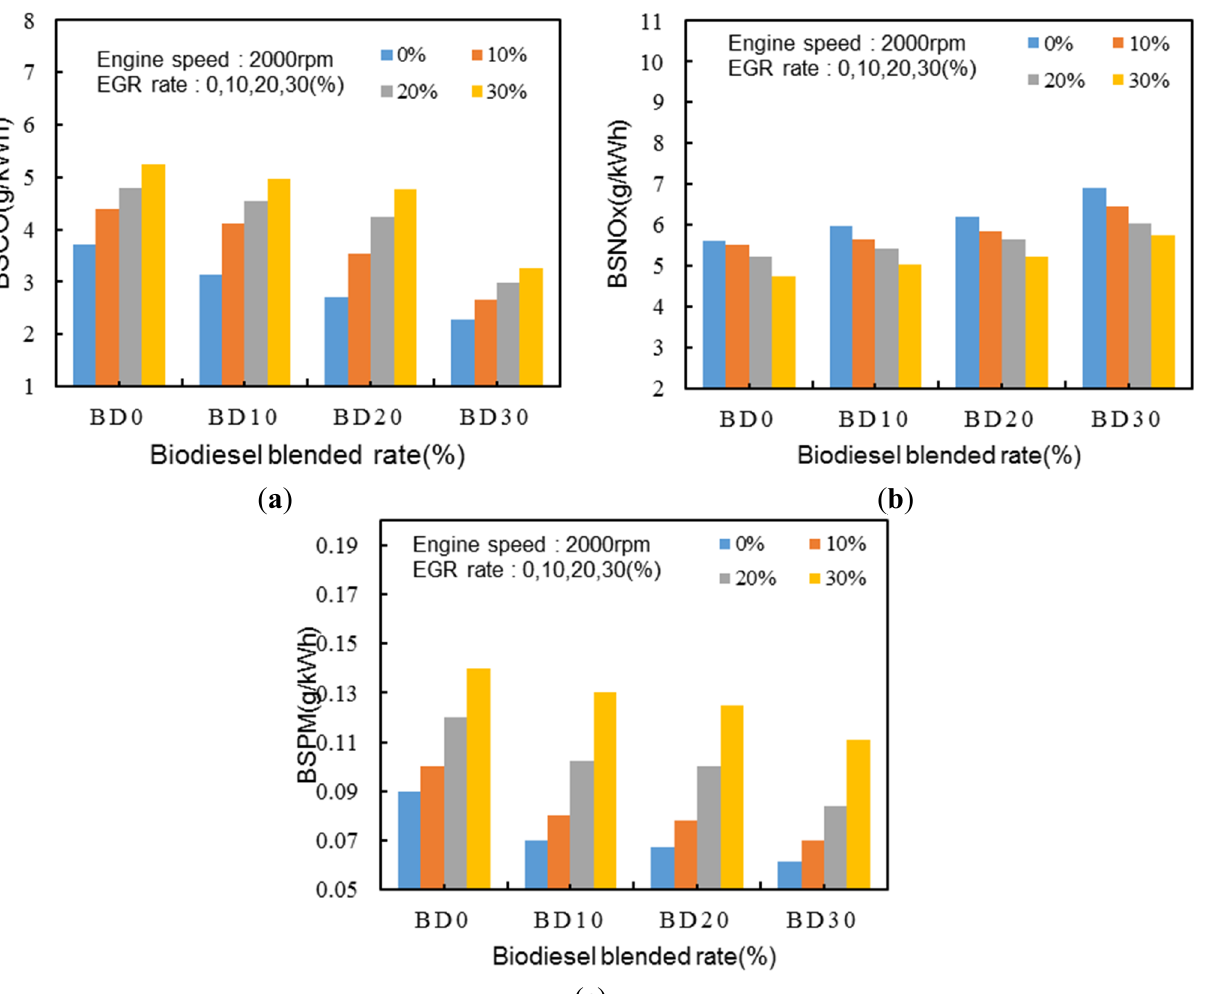
Figure 11. Effects of EGR and the biodiesel blend ratio on the ( a ) BSCO; ( b ) BSNO x ; and ( c )